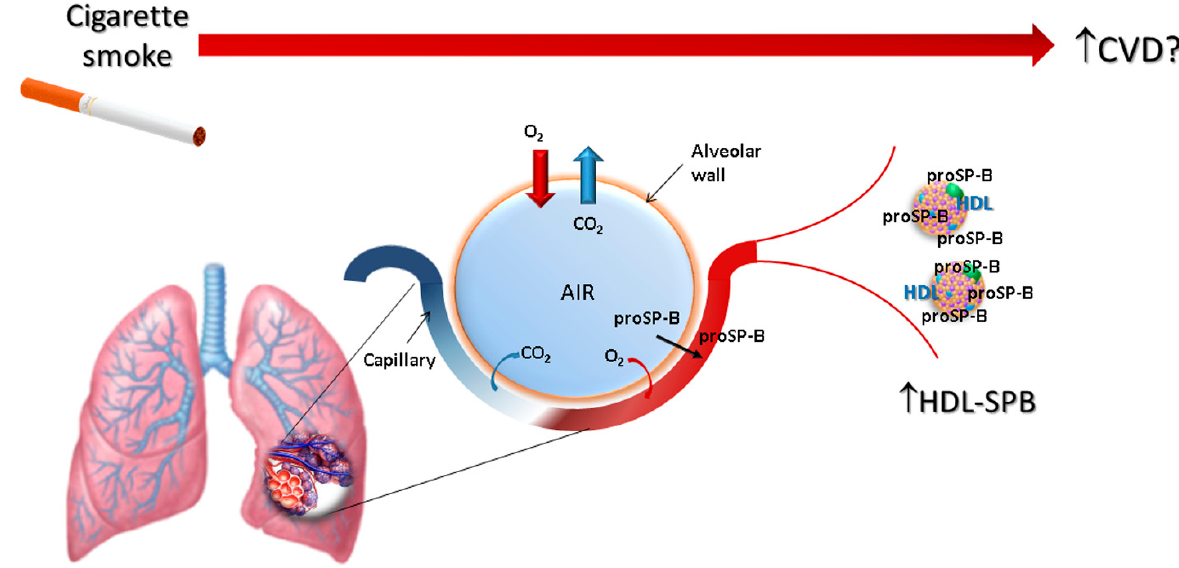
Figure 2. Schematic representation of the hypothesized process linking smoking with an increase of cardiovascular risk, involving the association of proSP-B with circulating HDL.